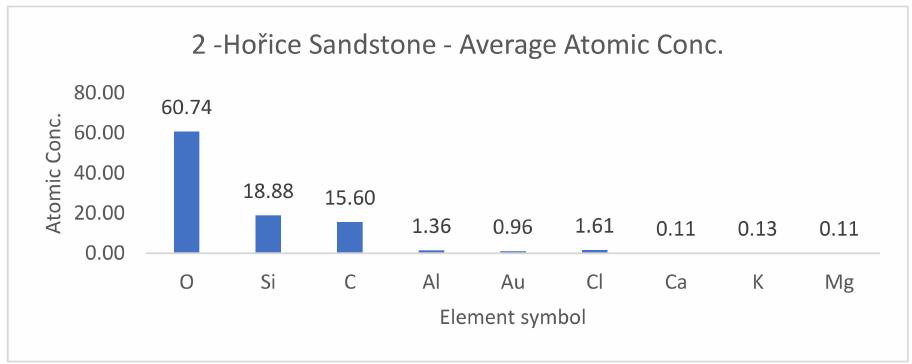
Figure 12. Hoˇrice sandstone average atomic concentration [%].